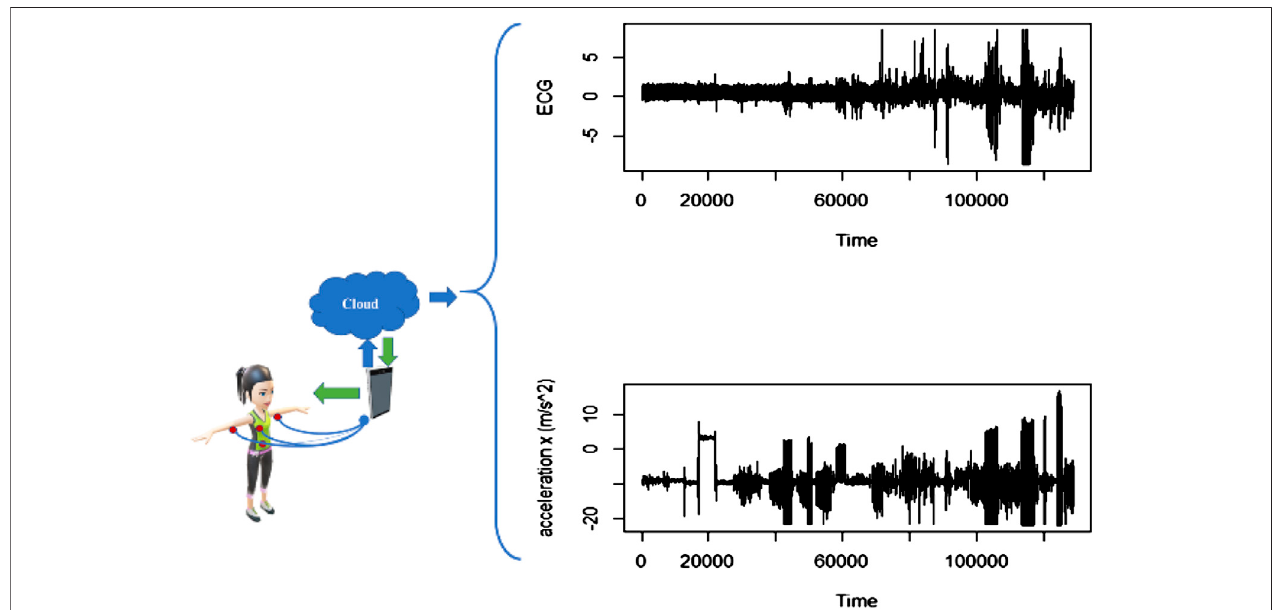
FIGURE 5 | Exemplary data obtained from patients wearing sensors to measure ECG and acceleration in three axes (x, y, z).